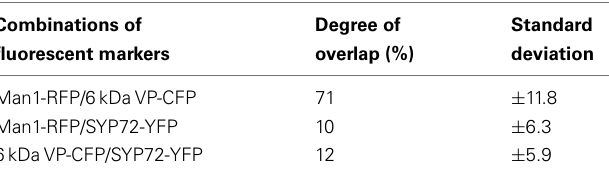
Table 1 | Degrees of overlap of Golgi, ERES, and ERIS markers in tobacco leaf epidermal